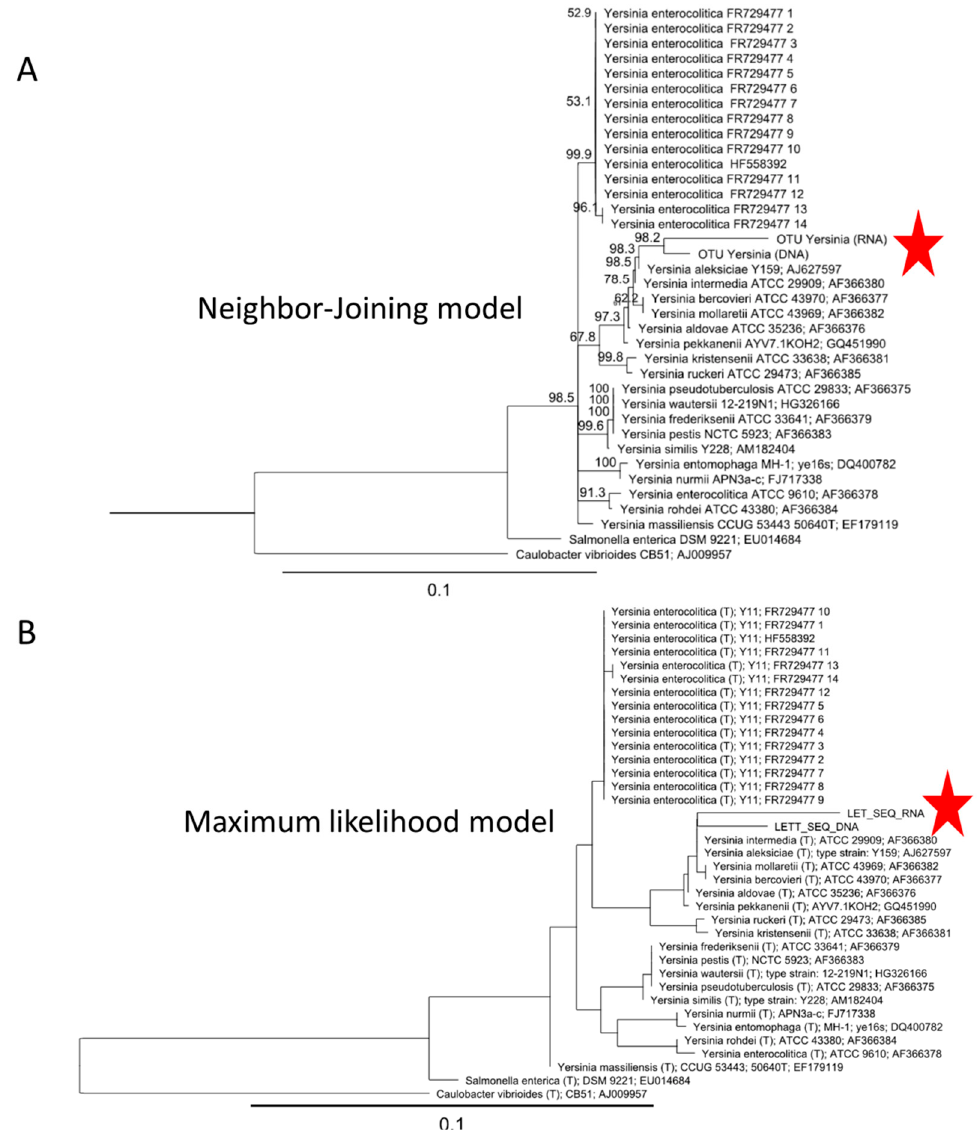
Figure 5. Phylogenetic tree of operational taxonomic units (OTUs) assigned to Yersinia spp. Reference type strains of all Yersinia species are included in the analysis. Yersinia OTUs obtained from the RTE salad samples are indicated with a red star. The consensus phylogenetic tree was calculated (×1000 replicates) based on neighbor-joining with a Jukes–Cantor substitution nucleotide model ( A ) and the maximum likelihood with the HK substitution nucleotide model (B ). Caulobacter vibrioides and Salmonella enterica were used as outgroups.